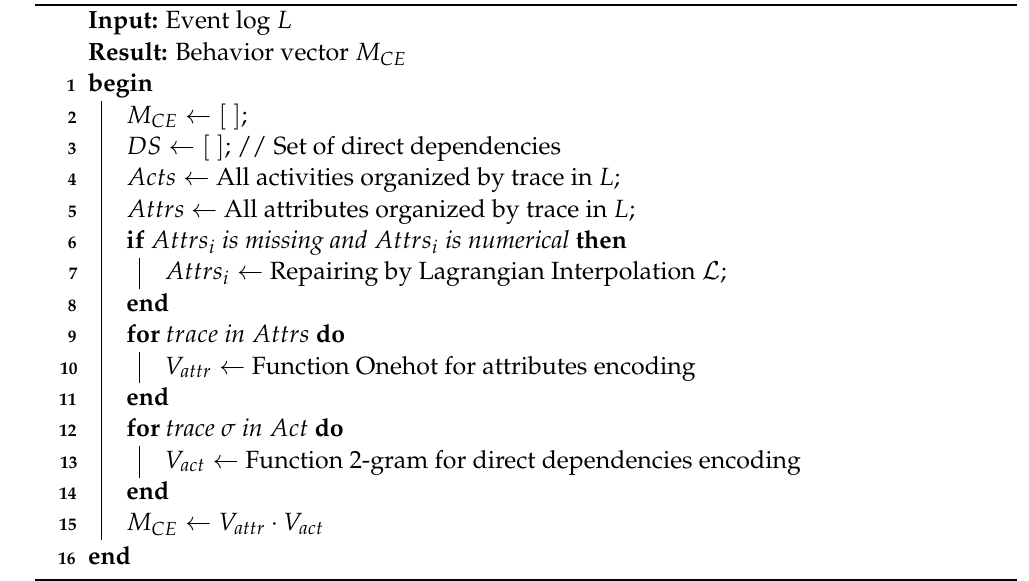
Algorithm 1: Construction of behavior vector M